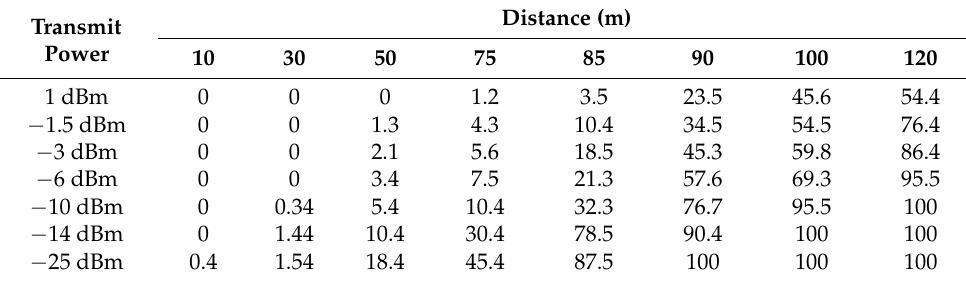
Table 11. Packet loss rate test (Improved-LEACH